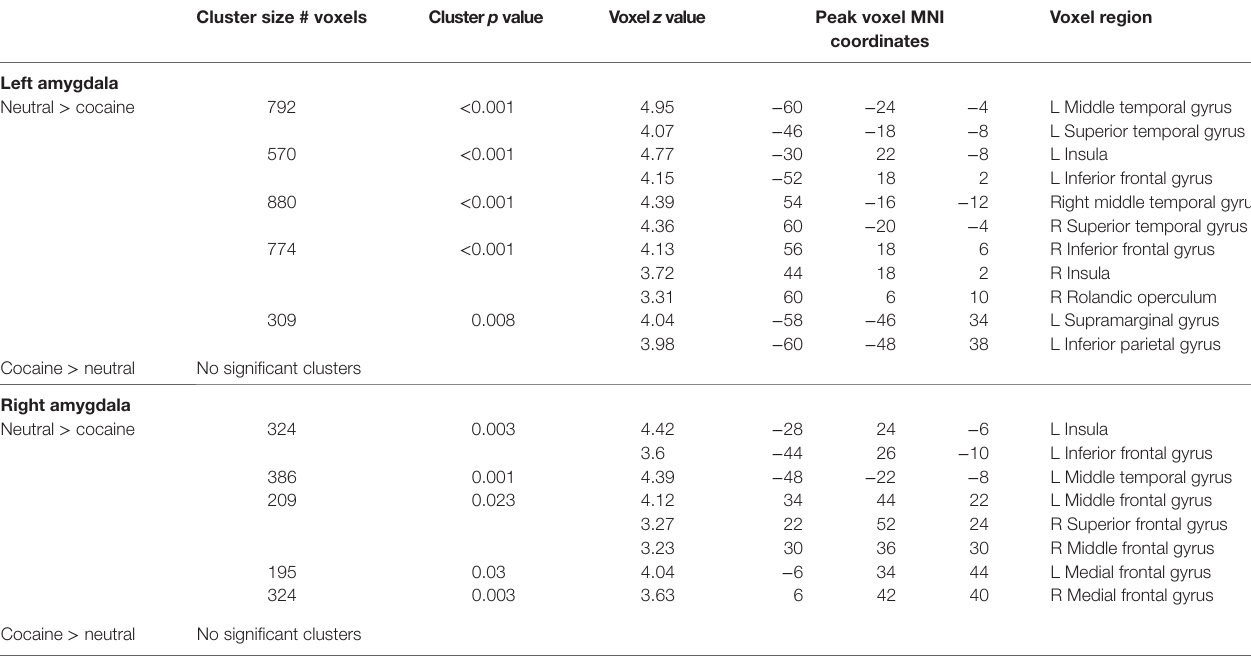
TaBle 3 | Differences in amygdala connectivity during the processing of cocaine and neutral cues (in cocaine users).